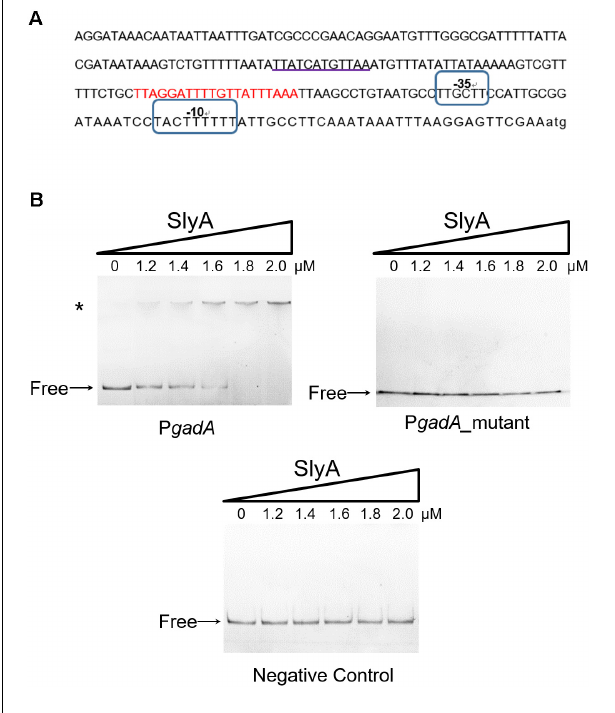
FIGURE 3 | SlyA directly binds to the promoter region of the gadA gene. (A) Bioinformatics analysis of the gadA promoter region (P gadA ). The sequence of the gadA promoter region of 224 bp upstream of the start codon is shown and the putative SlyA-binding site is underlined. Putative –10 and –35 elements are circled and the gad box is indicated in red. (B) EMSA experiments determined the direct binding of SlyA to P gadA . Different concentrations of purified SlyA (ranging from 0 to 2 µ M) were incubated with P gadA , P gadA lacking the SlyA-binding site (P gadA _mutant) or negative control DNA prior to electrophoretic separation. “Free” indicates free DNA and the asterisk indicates DNA-protein